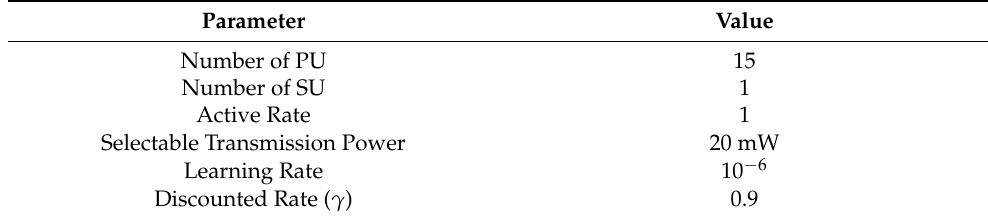
Table 1. Parameters of the first simulation (Single